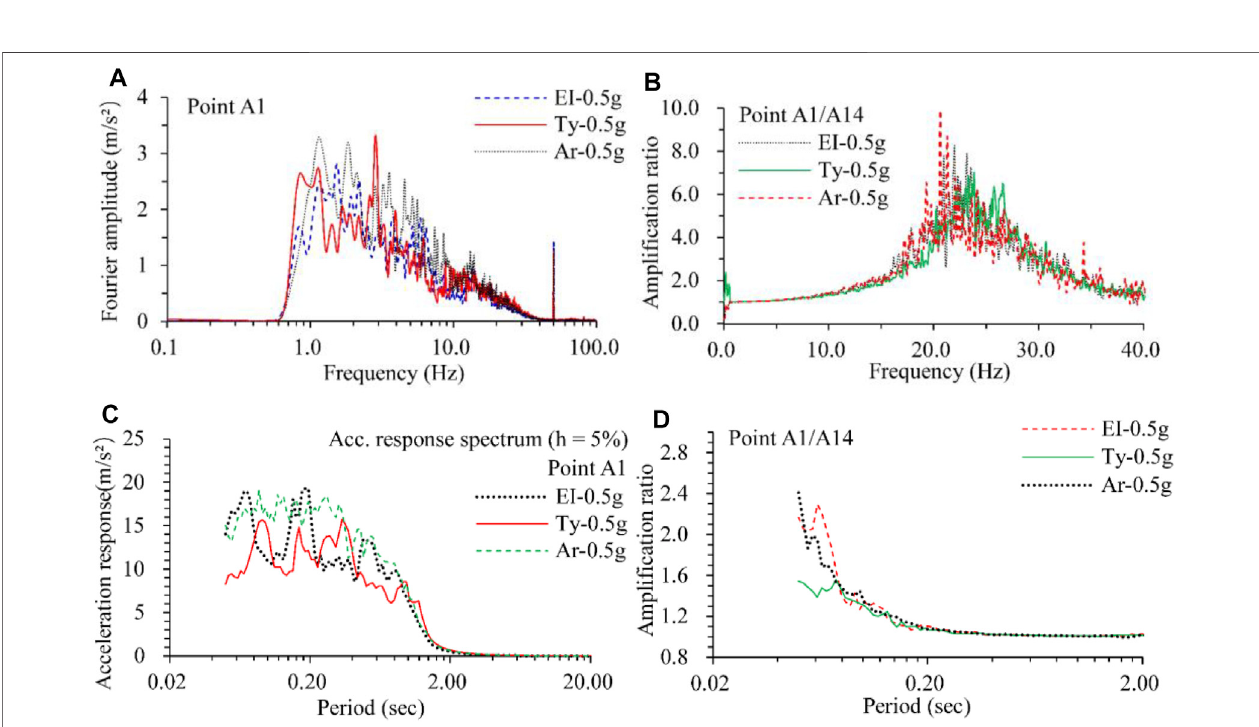
Frontiers in Earth Science |